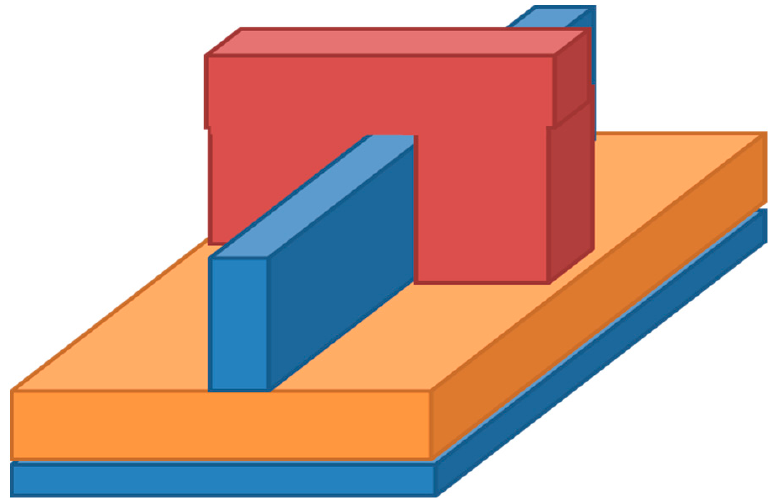
Figure 1. Device